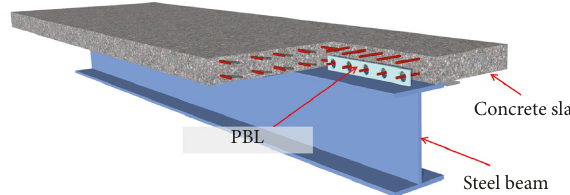
Figure 1: Schematics of the composite beam with PBL